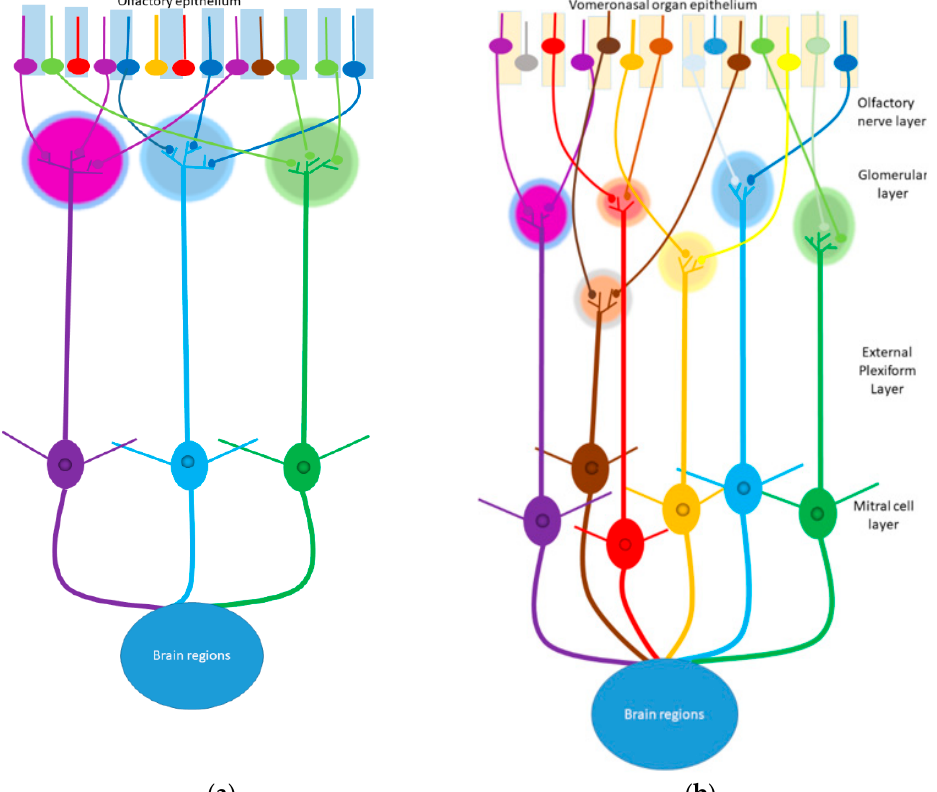
Figure 1. Schematic representation of sensory projections in the ( a ) main olfactory epithelium (MOE) and ( b ) vomeronasal organ (VNO). ( a ) Within the MOE, olfactory sensory neurons in the olfactory epithelium expressing the same specific odorant receptor have axons that innervate to the same glomerulus (represented by the different colours green, blue, and purple), which in turn excite specific mitral cells to act on specific brain regions. ( b ) Within the VNO, sensory neurons expressing the similar vomeronasal receptor innervate multiple small glomeruli, which excite mitral cells and thus specific brain regions. (Each colour represents a population of vomeronasal sensory neurons, that express one different type of vomeronasal receptor. Adapted from [161]. Unlike the separation between the MOE and the MOB, the vomeronasal epithelium is part of the vomeronasal organ (VNO) that is recessed, with detection relying on phero- mone molecules being dissolved in nasal mucus and being sucked into the lumen of the organ [153,154,162]. Access of stimuli to the lumen is modulated by the vasodilation/con- striction of blood vessels and sinuses lateral to the lumen [163–166], which is under hor- monal control and can be actively modulated by some pheromones [167]. Vomeronasal sensory neurons are found in a pseudostratified epithelium in the basal and apical aspects of the vomeronasal organ [153]. Pheromones cause membrane depolarisation and increase the action potential firing rate of sensory neurons in the VNO [168,169]; however, the sig- nal transduction cascade is largely unknown. Signals from the VNO sensory neurons ex- cite a given vomeronasal receptor and send axonal projections towards the anterior and posterior accessory olfactory bulb. Neurons that excite the same receptor have axons that merge into 10–30 glomeruli [154]. Differentially, inputs from neurons expressing different receptor types are received by one glomerulus [153,154]. Mitral cells of the accessory ol- factory bulb connect to the medial amygdala, posteromedial cortical amygdala, the acces- sory olfactory tract, and the bed nucleus of the stria terminalis [154,170]. Ultimately both the MOE and VNO pathway projections lead to specific areas of the amygdala and the hypothalamus modifying the behaviour and endocrinology of animals (Figure 2).